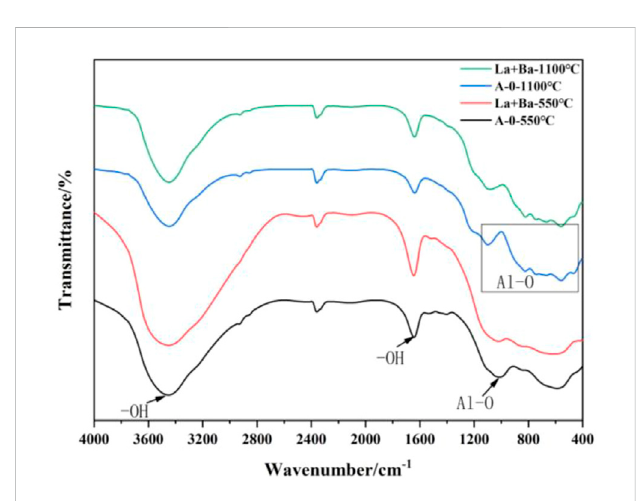
FIGURE 7 Infrared spectra of modi fi ed Al 2 O 3 before and after